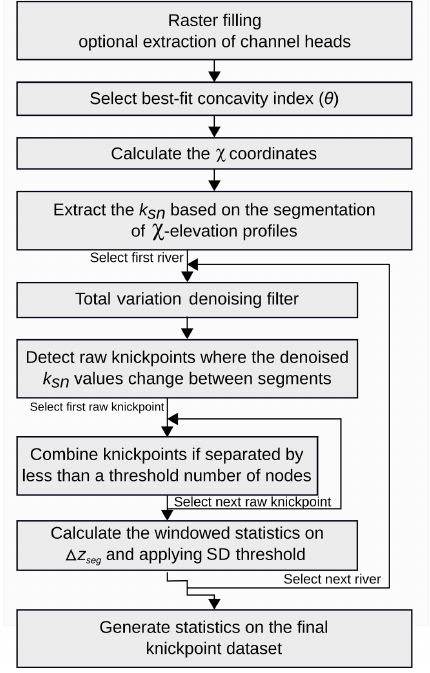
Figure 2. Flowchart of the knickpoint detection